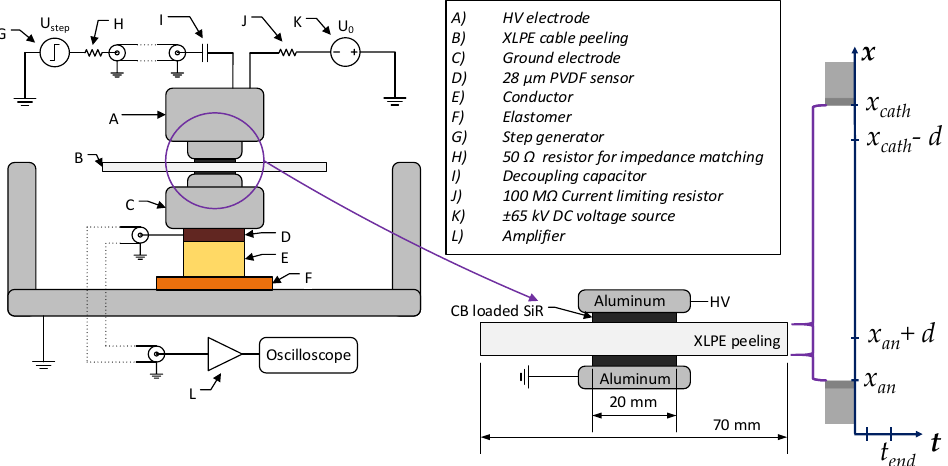
Figure 4. Illustration of the Pulsed-Electro-Acoustic (PEA) setup and the sample configuration. Also, measurement dimensions ( x, t ) are indicated.